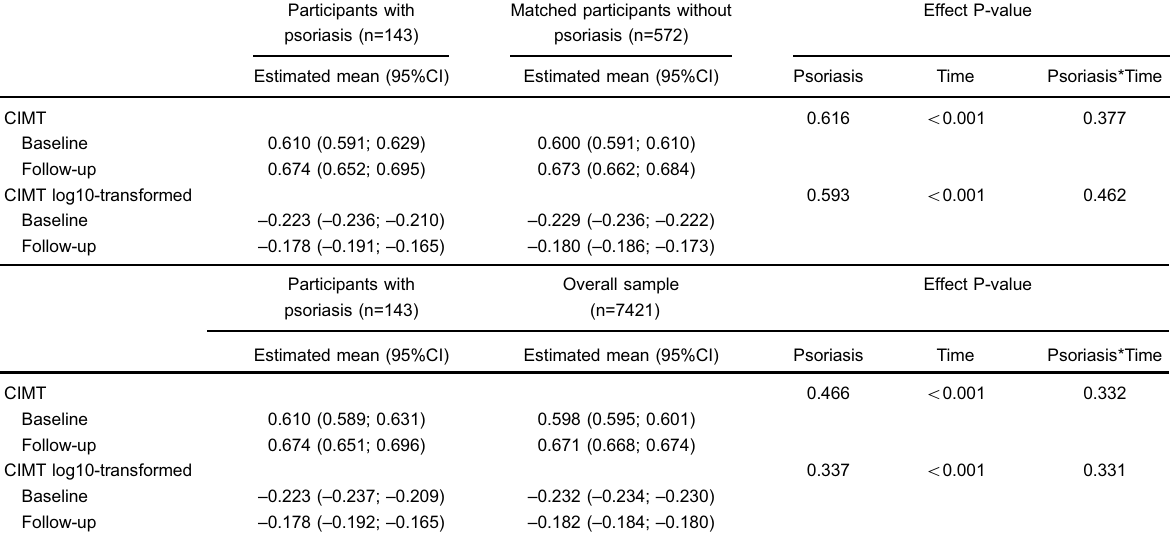
Table 3. Repeated measures ANOVA of carotid intima-media thickness at baseline and at the 8-year follow-up of ELSA-Brasil cohort participants, according to psoriasis diagnosis